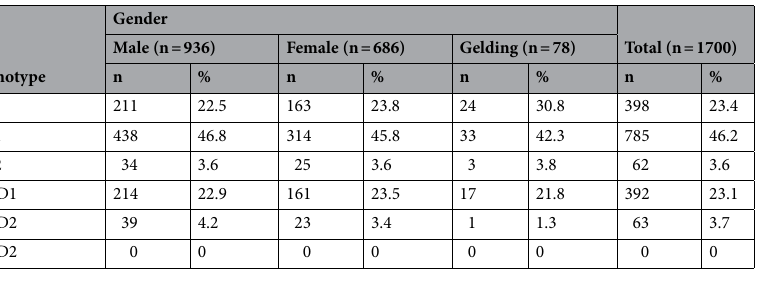
Table 1. Incidence of insertion/deletion polymorphism of eHRG gene in Thoroughbred horses. II, Insertion/ insertion; ID1, Insertion/45 bp deletion; ID2, Insertion/90 bp deletion; D1/D1, 45 bp deletion/45 bp